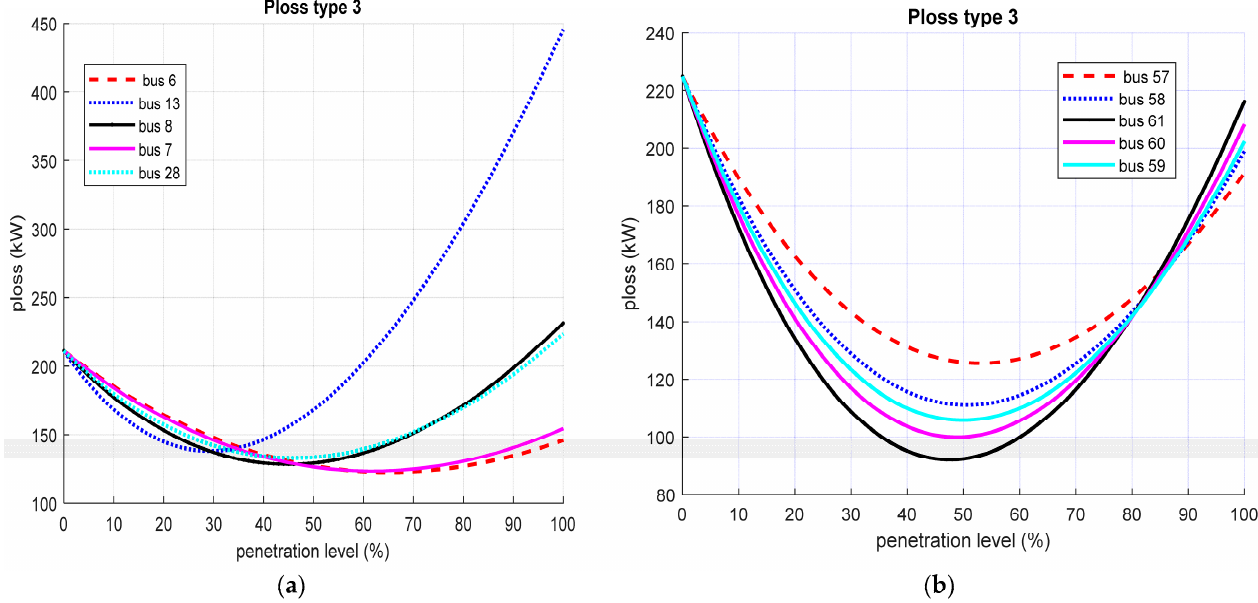
Figure 19. Real power loss when Type 3 DG was connected to selected buses of IEEE ( a ) 33-bus ( b ) 69-bus RDNs.